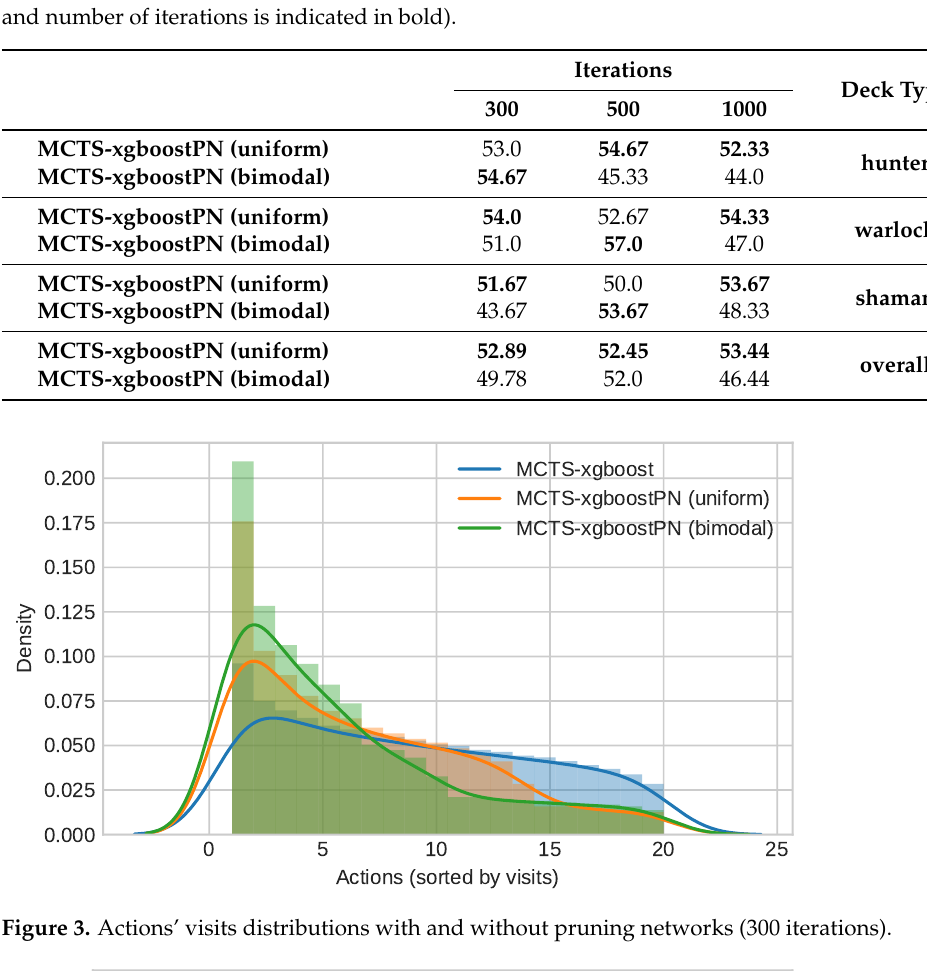
Table 4. Win rate per number of iterations against MCTS-xgboost (the highest win rate per deck type and number of iterations is indicated in bold).